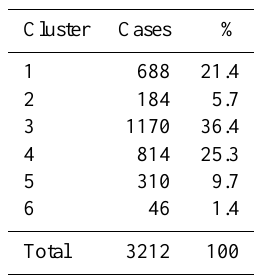
Table 1. Number of cases in each cluster. Table 2. Summary of aerosol